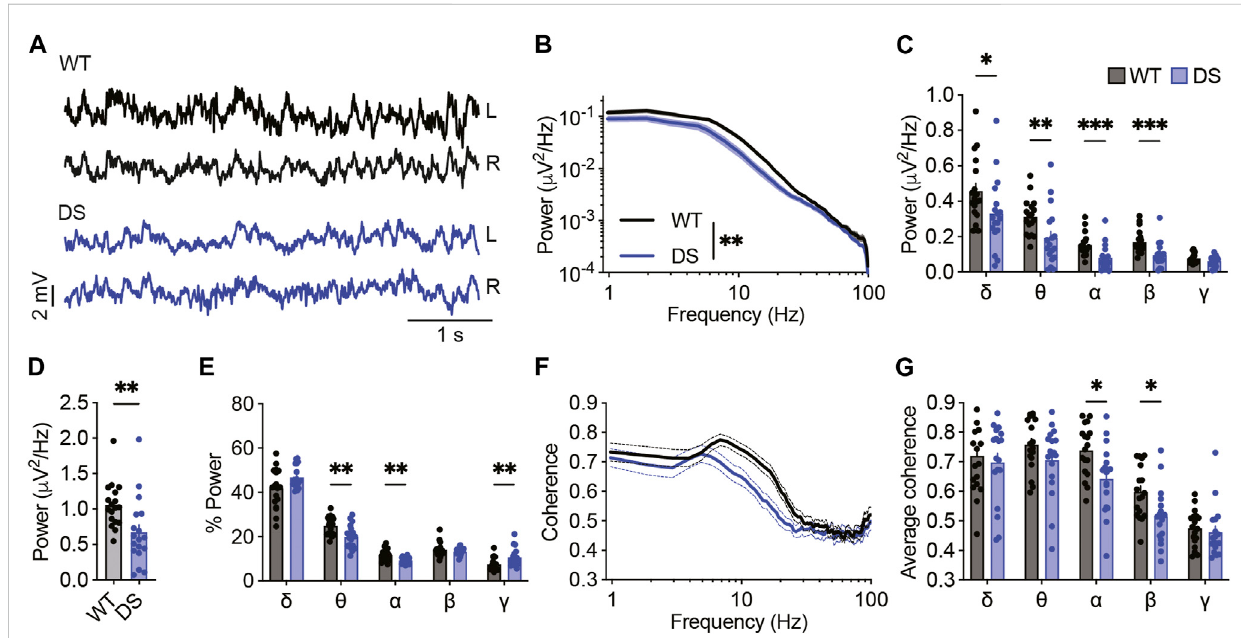
FIGURE 1 Reduced power of background activity and interhemispheric coherence in DS mice. (A) Representative traces of background ECoGs in WT and DS mice. (B) ECoGpowerdensitypro fi les. (C) Totalpowerforthefollowingfrequencybands: δ ,0.9 – 3.9 Hz; θ ,4.8 – 7.8 Hz; α ,8.7 – 11.7 Hz; β ,12.6 – 29.2 Hz; γ , 30.2 – 99.6 Hz. (D) Total power. (E) The relative power (%) of each frequency band. (F) Interhemispheric coherence plotted over the 1 – 100 Hz spectrum. (G) The mean interhemispheric coherence for each frequency band. WT, n = 18; DS, n = 18. * p < 0.05, ** p < 0.01, *** p <